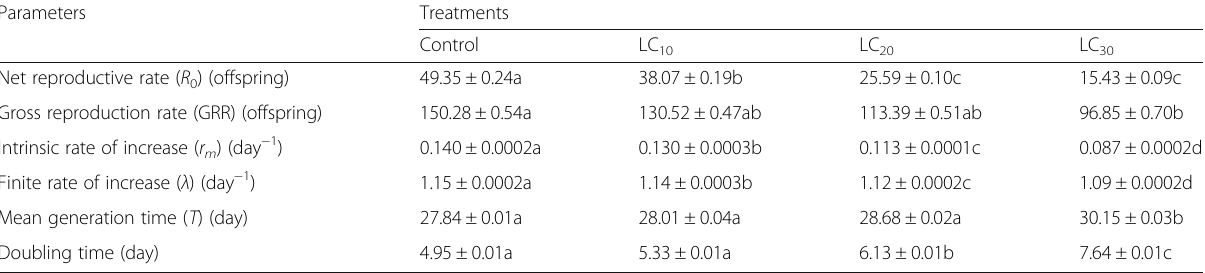
Table 4 Mean (± SE) life table parameters of Tuta absoluta treated with different sub-lethal concentrations of Metarhizium anisopliae